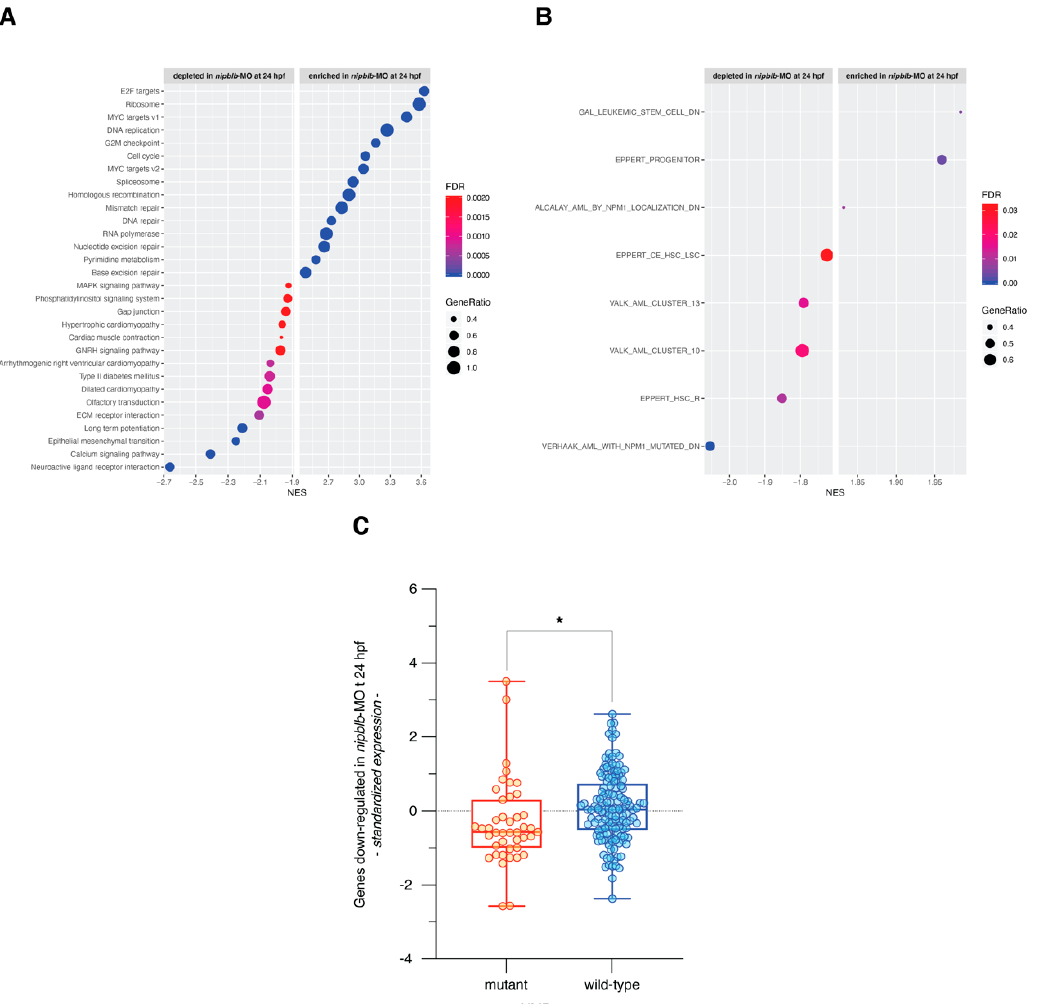
Figure 4. ( A ) Dot plot of the top 15 significantly enriched (normalized enrichment score NES > 0 and FDR ≤ 0.05) and depleted (normalized enrichment score NES < 0 and FDR ≤ 0.05) gene sets from Gene Set Enrichment Analysis of nipblb -MO at 24 hpf as compared to their ctrl-MO counterpart. Dot color indicates statistical significance of the enrichment (false discovery rate FDR), dot size represents the fraction of genes annotated to each term. Gene sets are ranked in decreasing order based on the NES value. ( B ) Dot plot of the significantly enriched (normalized enrichment score NES > 0 and FDR ≤ 0.05) and depleted (normalized enrichment score NES < 0 and FDR ≤ 0.05) myeloid differentiation and AML-related gene sets from Gene Set Enrichment Analysis of nipblb -MO at 24 hpf as compared to their ctrl-MO counterpart. ( C ) Average expression in NMP1 mutant and wild-type AMLs of 3972 genes down-regulated by nipblb loss-of-function at 24 hpf (* p = 0.016 in unpaired t -test) .